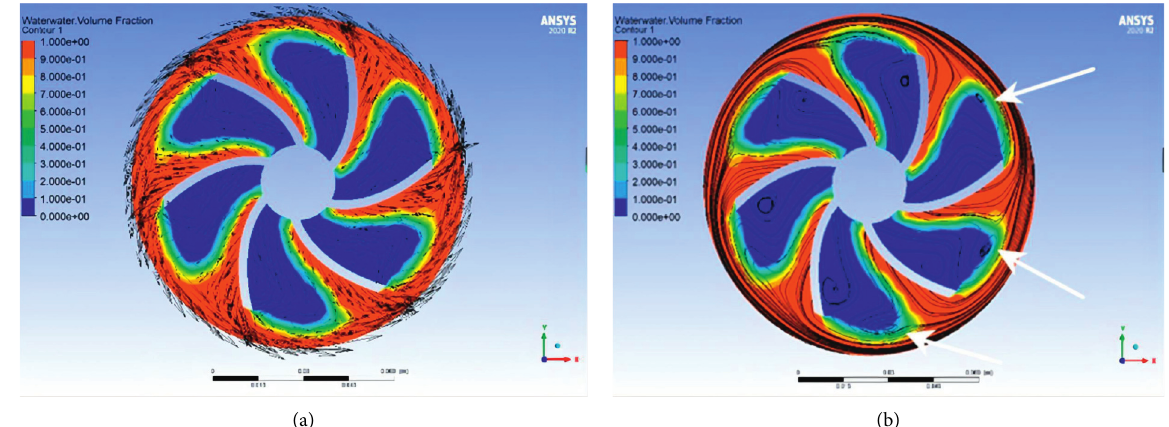
Figure 16: Gas-liquid distribution map: (a) Velocity vector and (b) flow